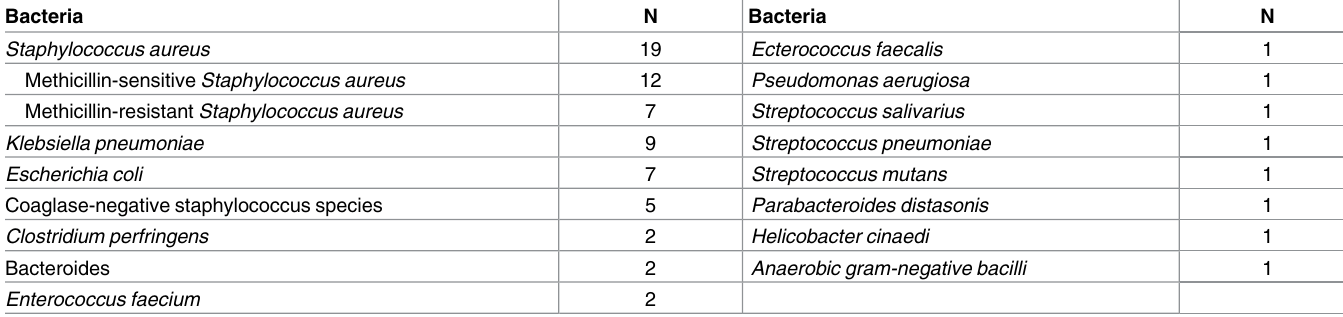
Table 2. Pathogens of bacteremia. Bacteria N Bacteria